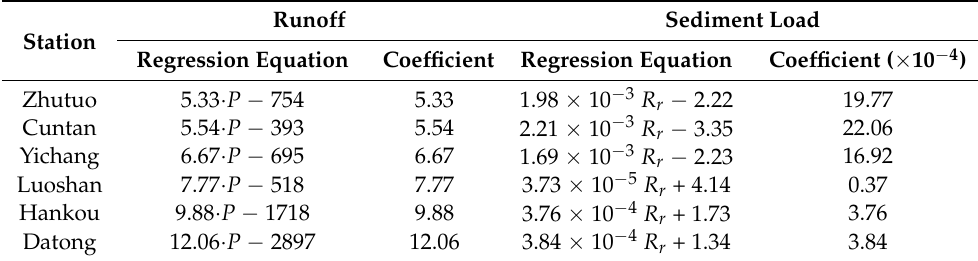
Table 4. Regression equations and